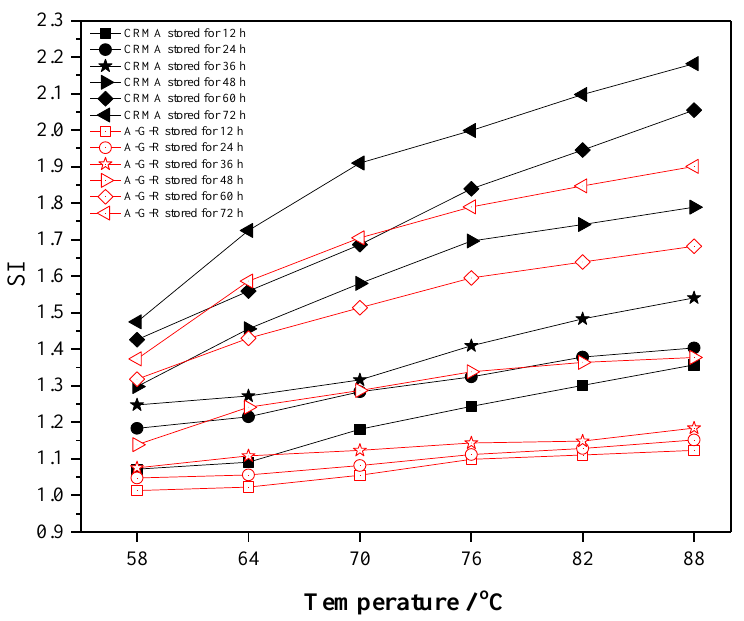
Figure 12. The separation index ( SI ) curves of CRMA and A–G–R.